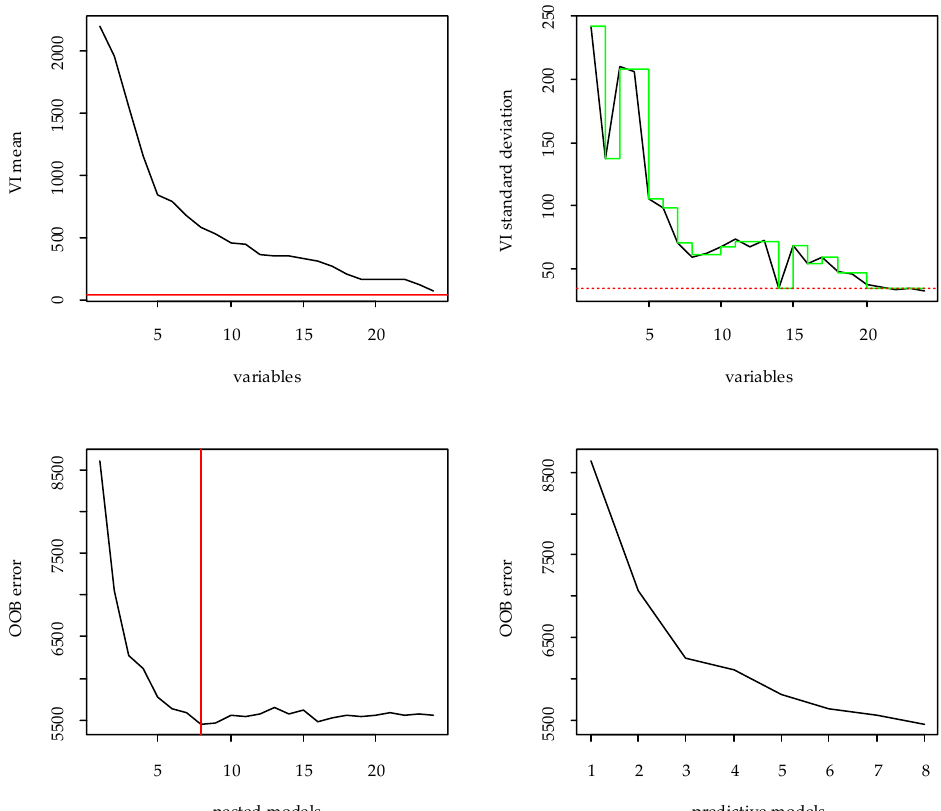
Figure 4. The variable selection based on the VSURF package. The top graphs illustrate the removal of the negative importance variables’ threshold based on the VI mean (left, the horizontal red solid line represents the threshold position) and VI standard deviation (right, the green piece-wise line represents prediction values given by a CART model and the horizontal red dotted line represents the minimum prediction value), and the bottom graphs are related to the interpretation (left, the vertical red solid line represents the minimum error position) and prediction (right) and show the number of variables selected according to the OOB error.